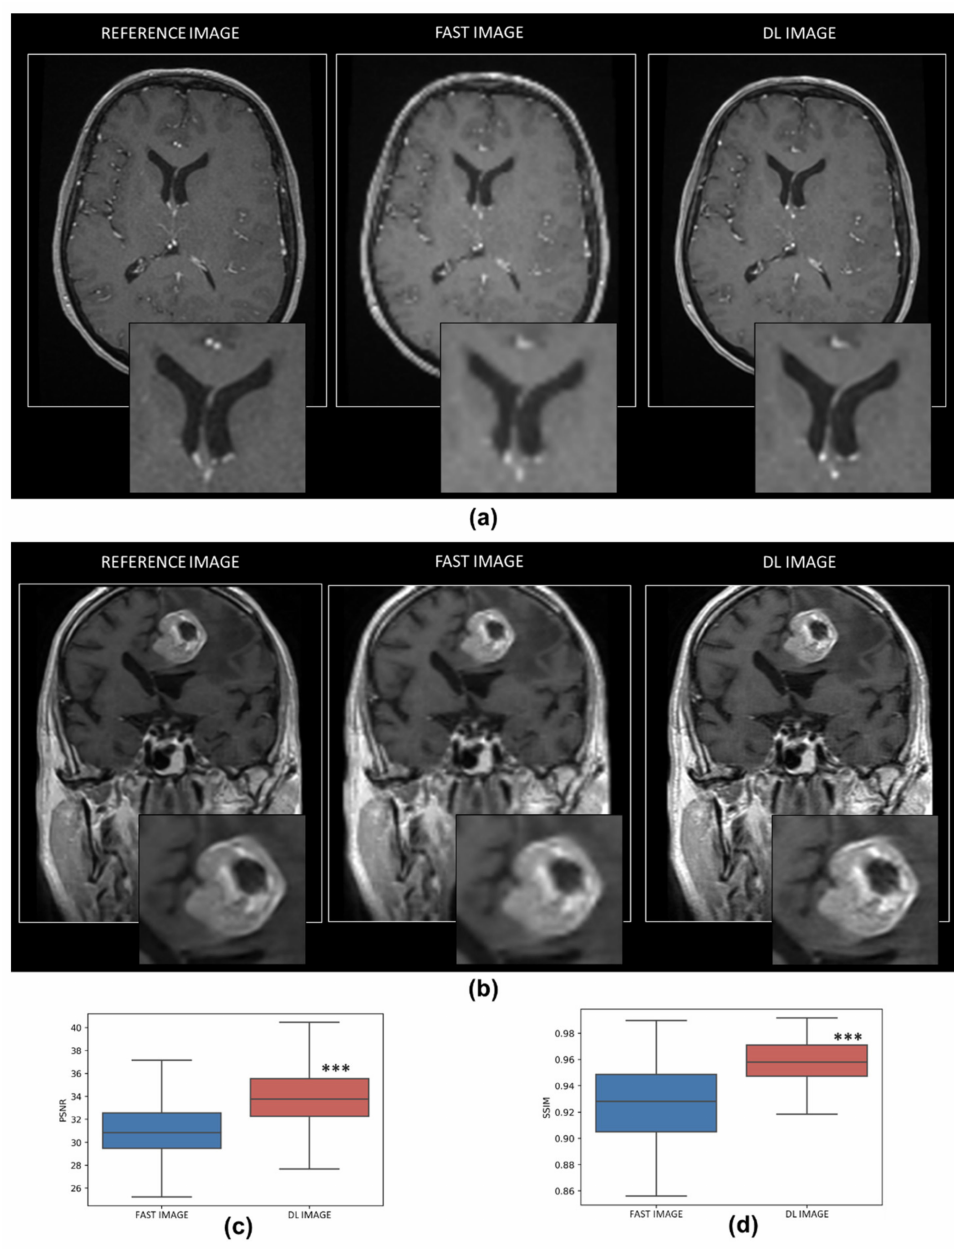
Figure 2. Resampling DL model. Representative magnetic resonance imaging (MRI) of reference images, fast acquisition images and DL reconstruction images in healthy ( a ) and pathological conditions ( b ). Quantitative analysis of the efficiency of the resampling DL model with the compari- son with fast acquired image concerning PSNR ( c ) and SSIM ( d ) metrics. n = 2049 for both groups, *** p < 0.001 vs. fast acquired